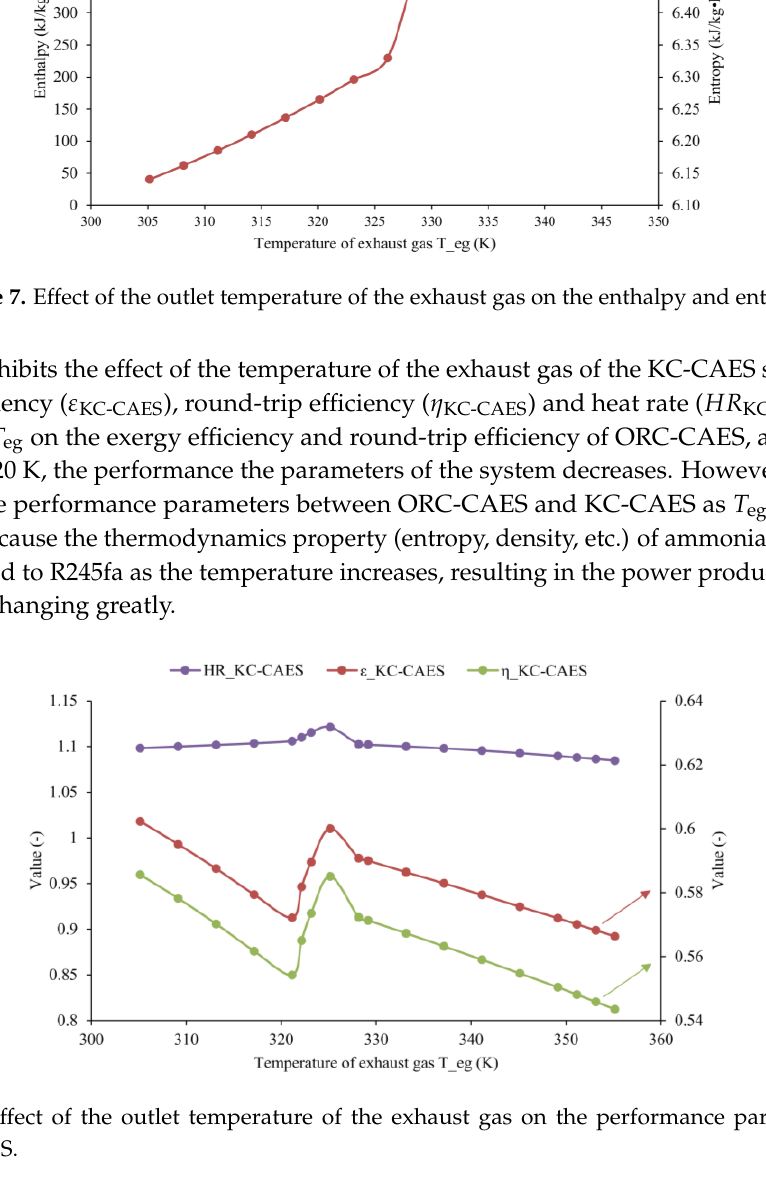
Figure 6. Effect of the outlet temperature of the exhaust gas on the performance parameters of the ORC-CAES.